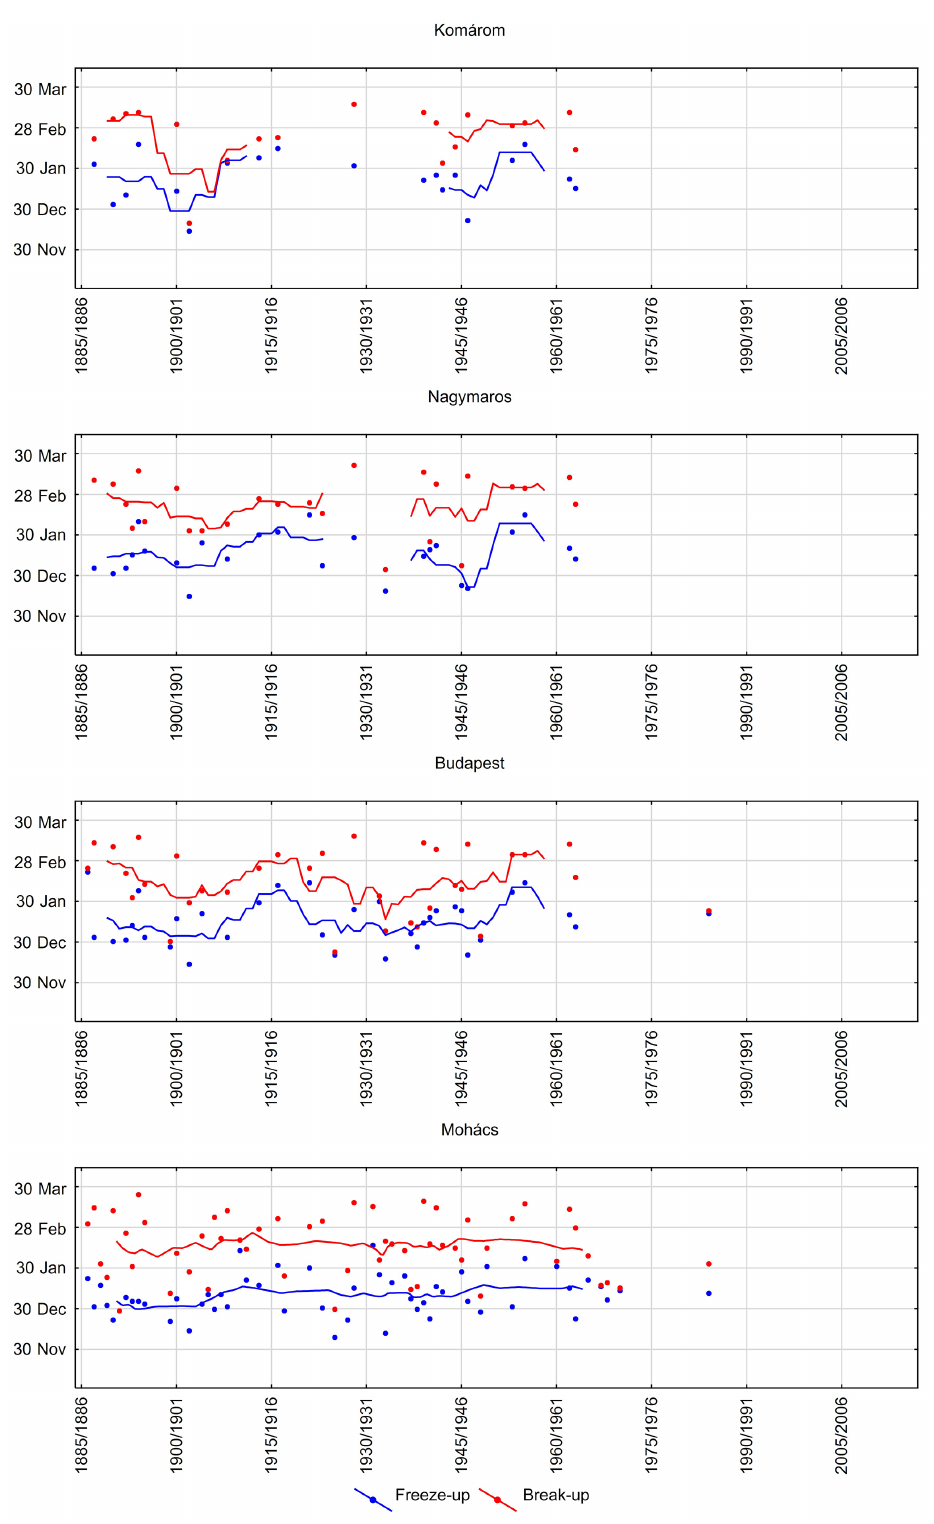
Figure 5. Variations of the date of freeze-up and break-up on the River Danube from 1885 to 2017. (Blue and red curves are 10-year moving